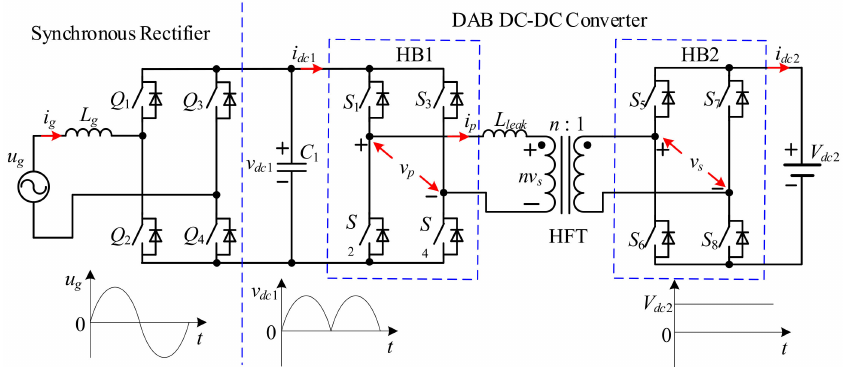
Figure 1. Schematic of Q1S AC-DC converter.